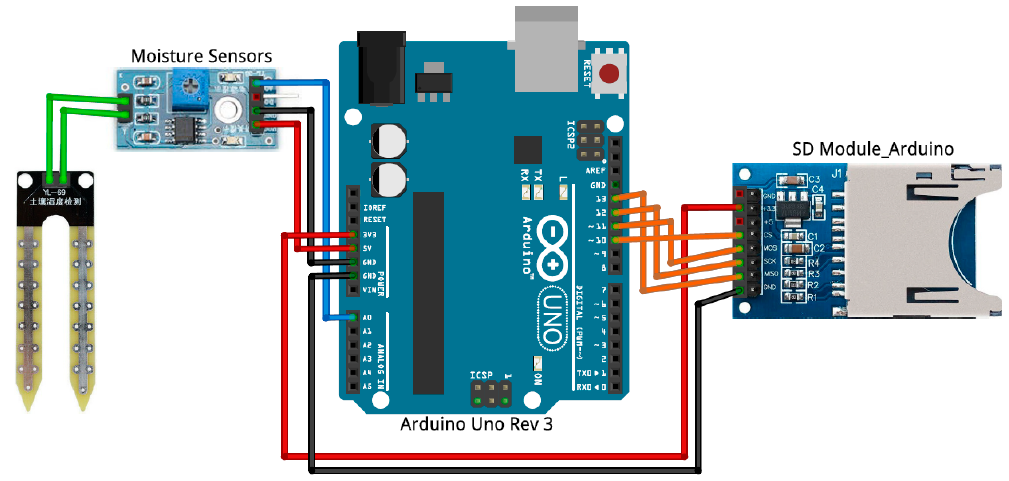
Figure 4. Arduino sensor connection diagram.